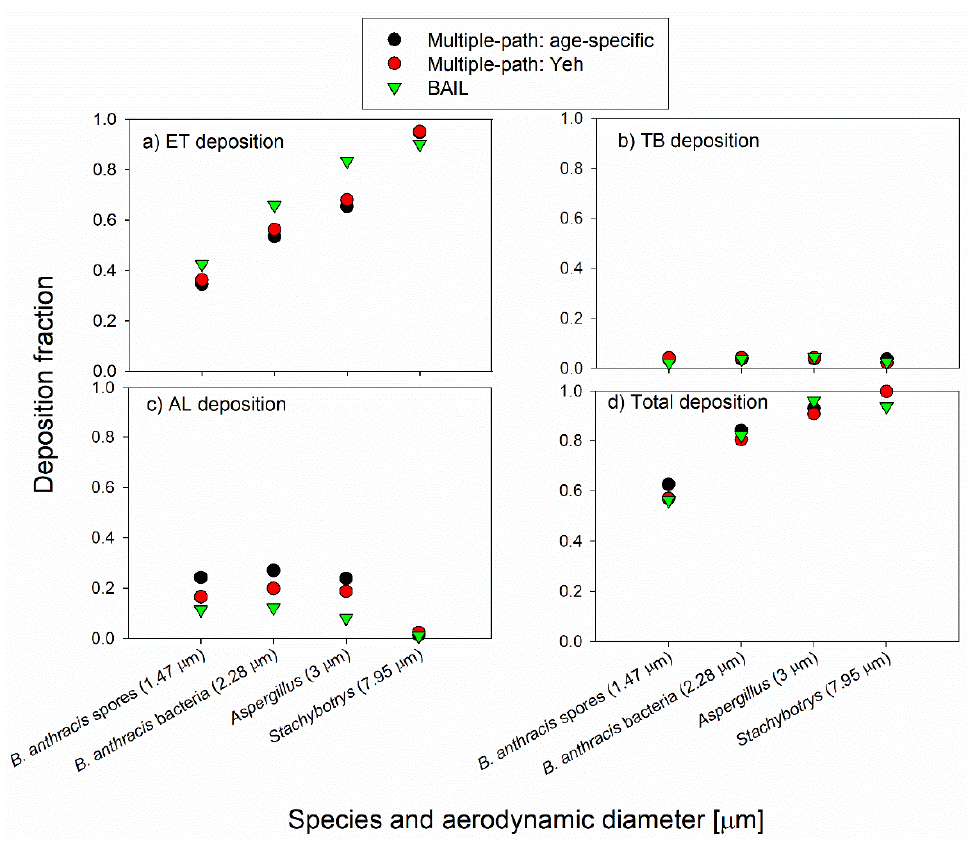
Figure 3. Regional and total deposition fraction for the light exercise scenario: ( a ) ET deposition, ( b ) TB deposition, ( c ) AL deposition, and ( d ) total deposition.